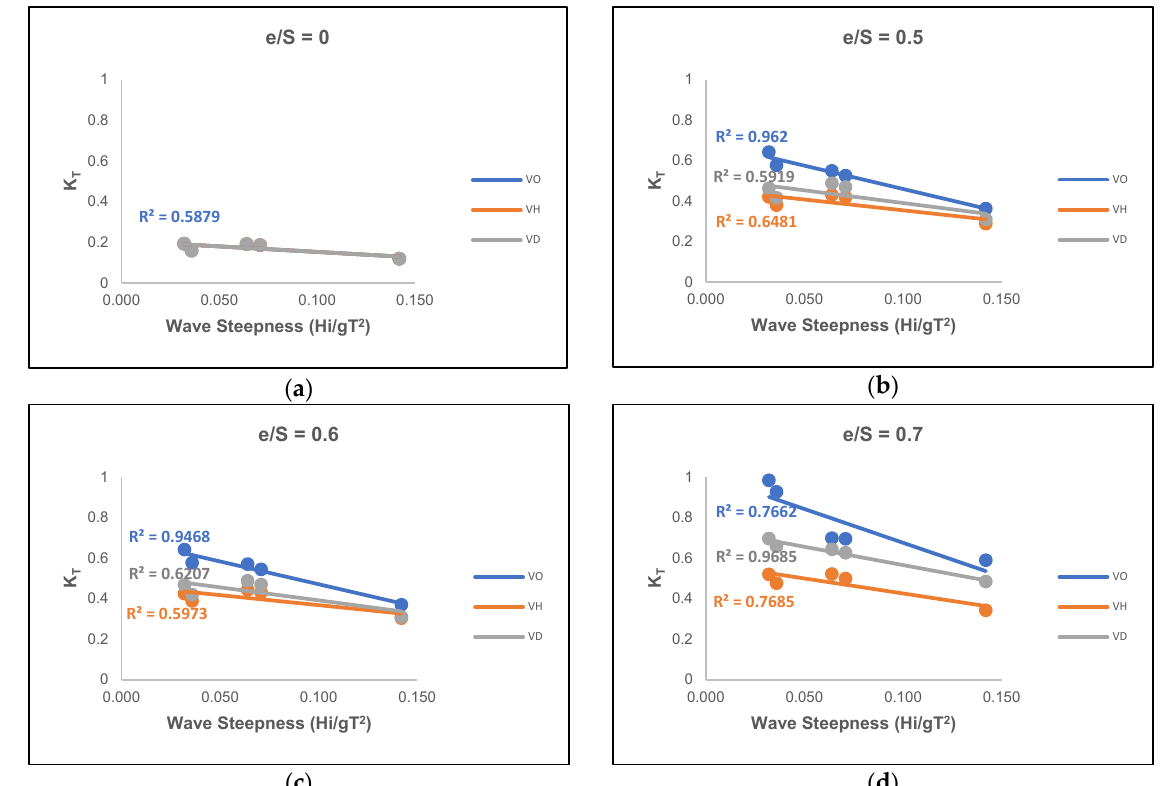
Figure 7. The influences of three bamboo formations are plotted along wave steepness for different e/S ( the ratio between end-to-end spacing ( e ) and center-to-center spacing (S)): ( a ) e/S = 0 or no gap; ( b ) e/S = 0.5; ( c ) e/S = 0.6 ; ( d ) e/S = 0.7.